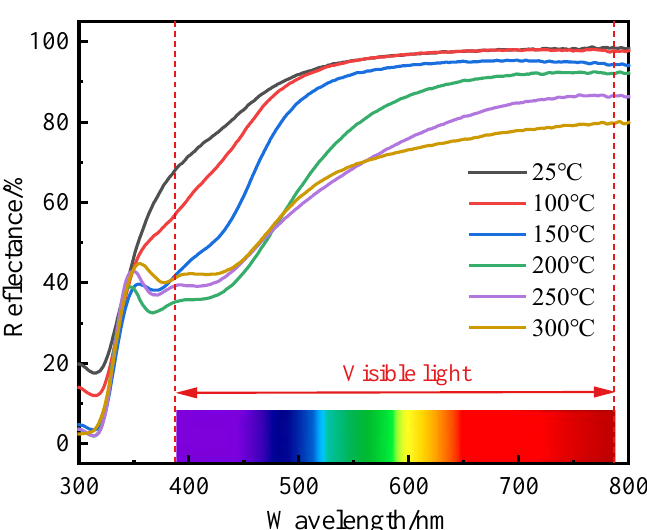
Figure 4. Reflectance spectra of the ITO/AgIn/ITO films as a function of sputtering temperature.